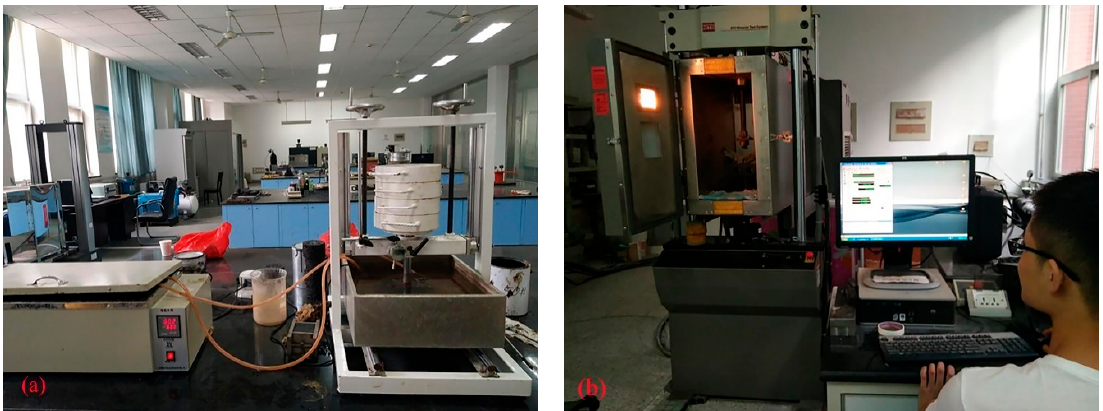
Figure 1. Performance test, ( a ) indentation test; ( b ) Low-temperature bending